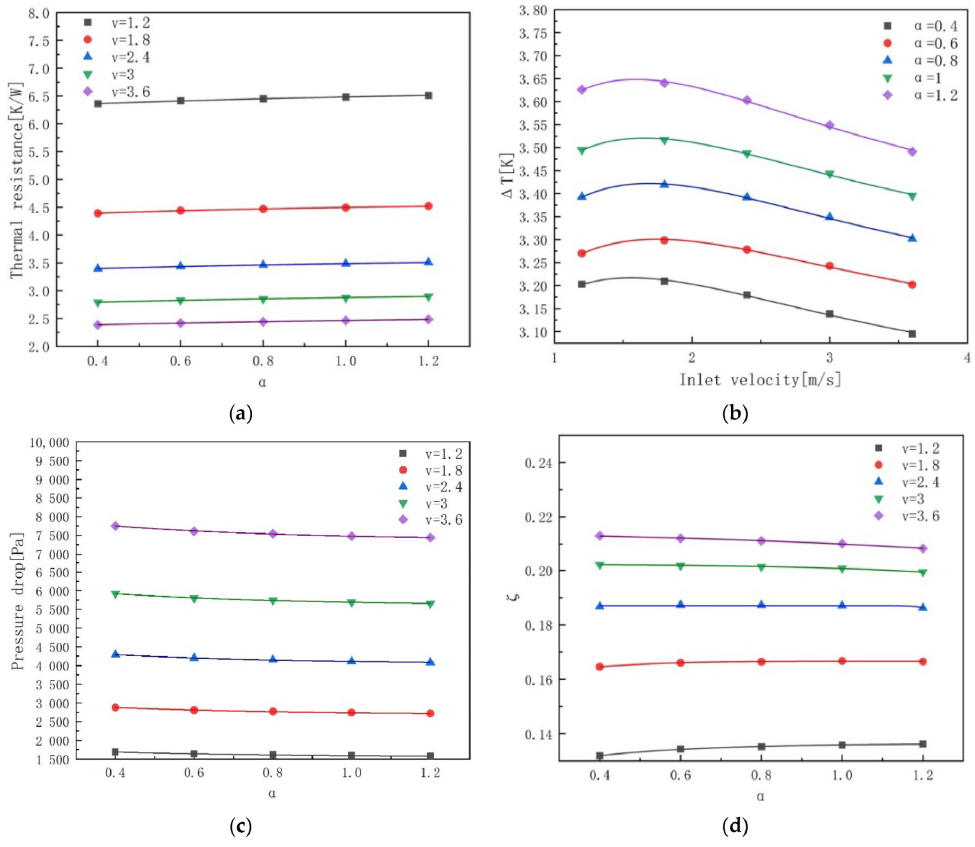
Figure 13. Flow and heat transfer performance of the double-layer MMC with various height ratios: ( a ) thermal resistance; ( b ) maximum temperature difference; ( c ) pressure drops; and ( d ) comprehensive